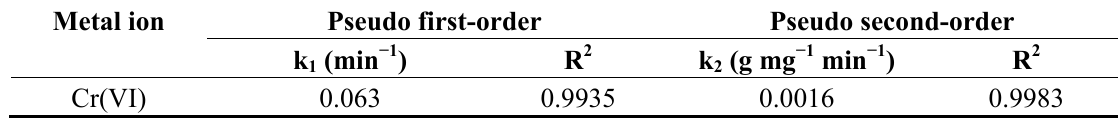
Table 3. Kinetic parameters for Cr(VI) adsorption on HGCTS.